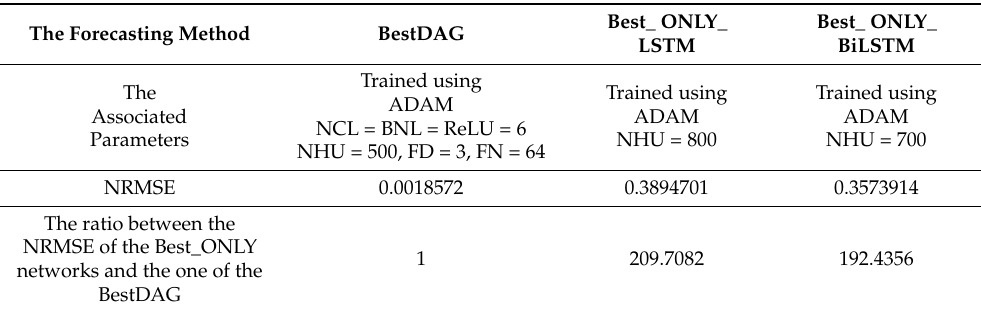
Table 4. A summary of the comparison of the BestDAG with other single methods’ forecasting accuracy. The Forecasting